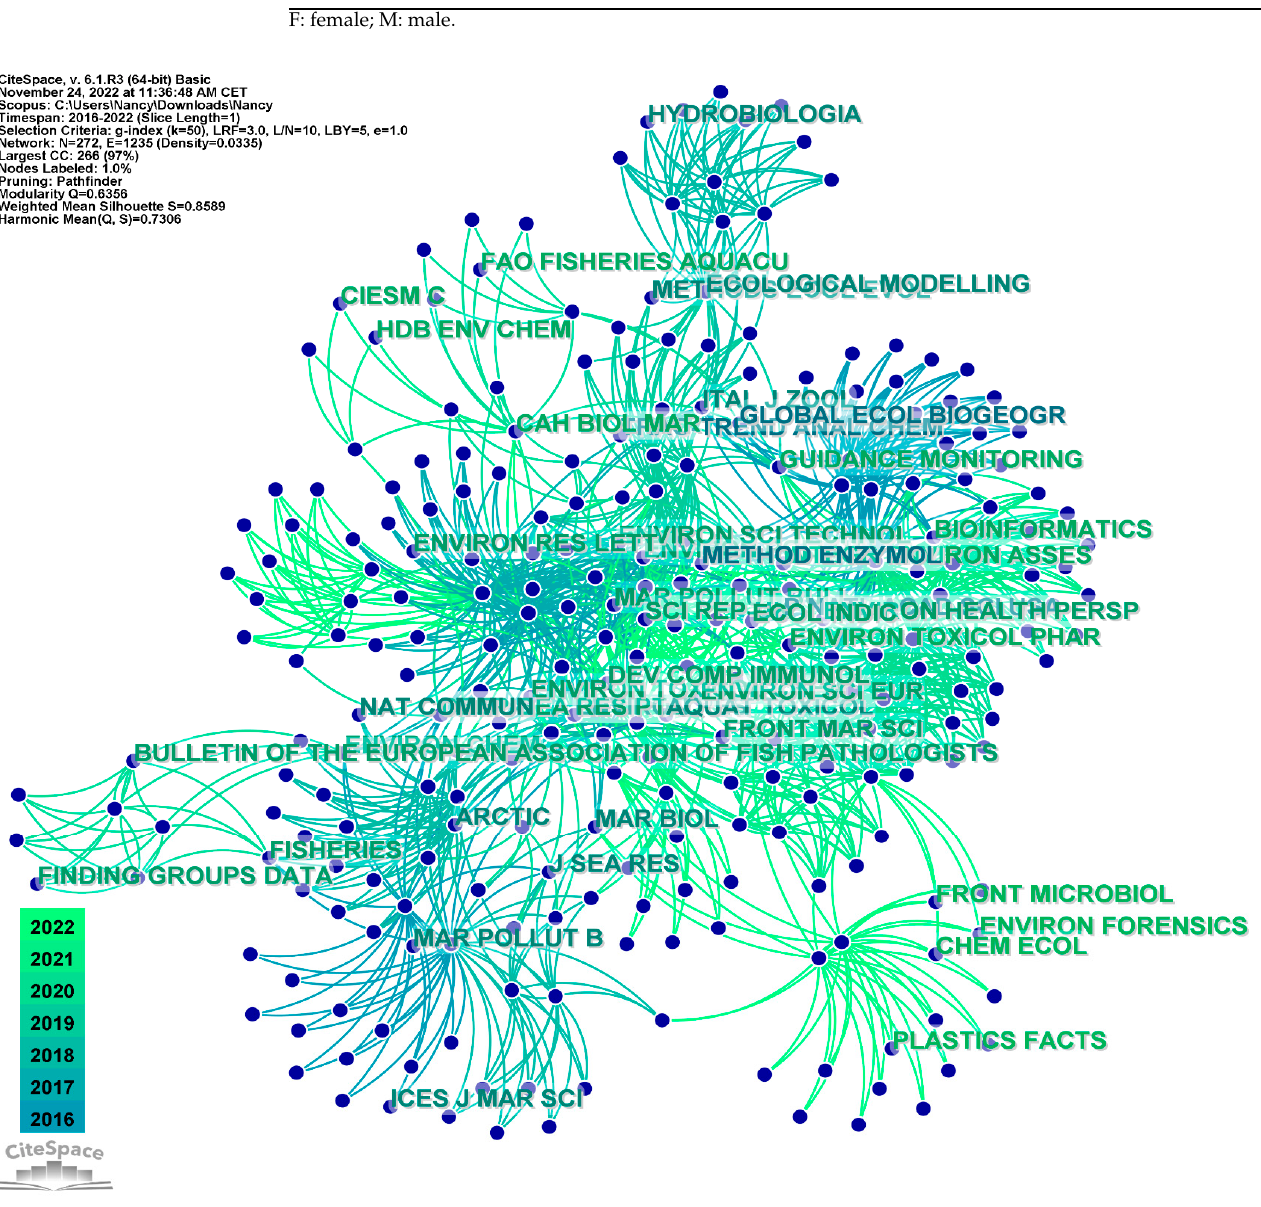
Figure 5. Cited journal networks.